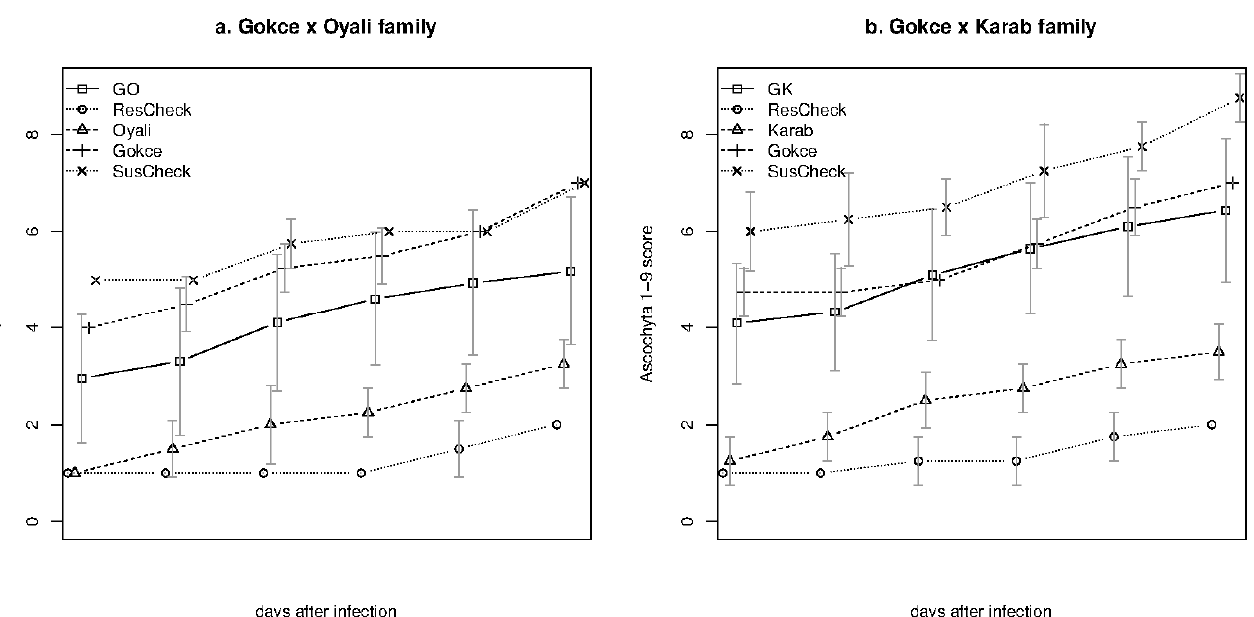
Figure 2. Ascochyta disease severity progression for the chickpea Gokce × Oyali ( a ) and Gokce × Karab families ( b ), parents, and check lines. Line types are Gokce × Oyali family (GO), Gokce × Karab family (GK), resistant check (ResCheck), susceptible check (SusCheck), or parental lines (Gokce, Oyali, and Karab). Plotting symbols and vertical lines show mean disease severity at each time period, respectively. Time periods for each line have been staggered slightly to better show error values.